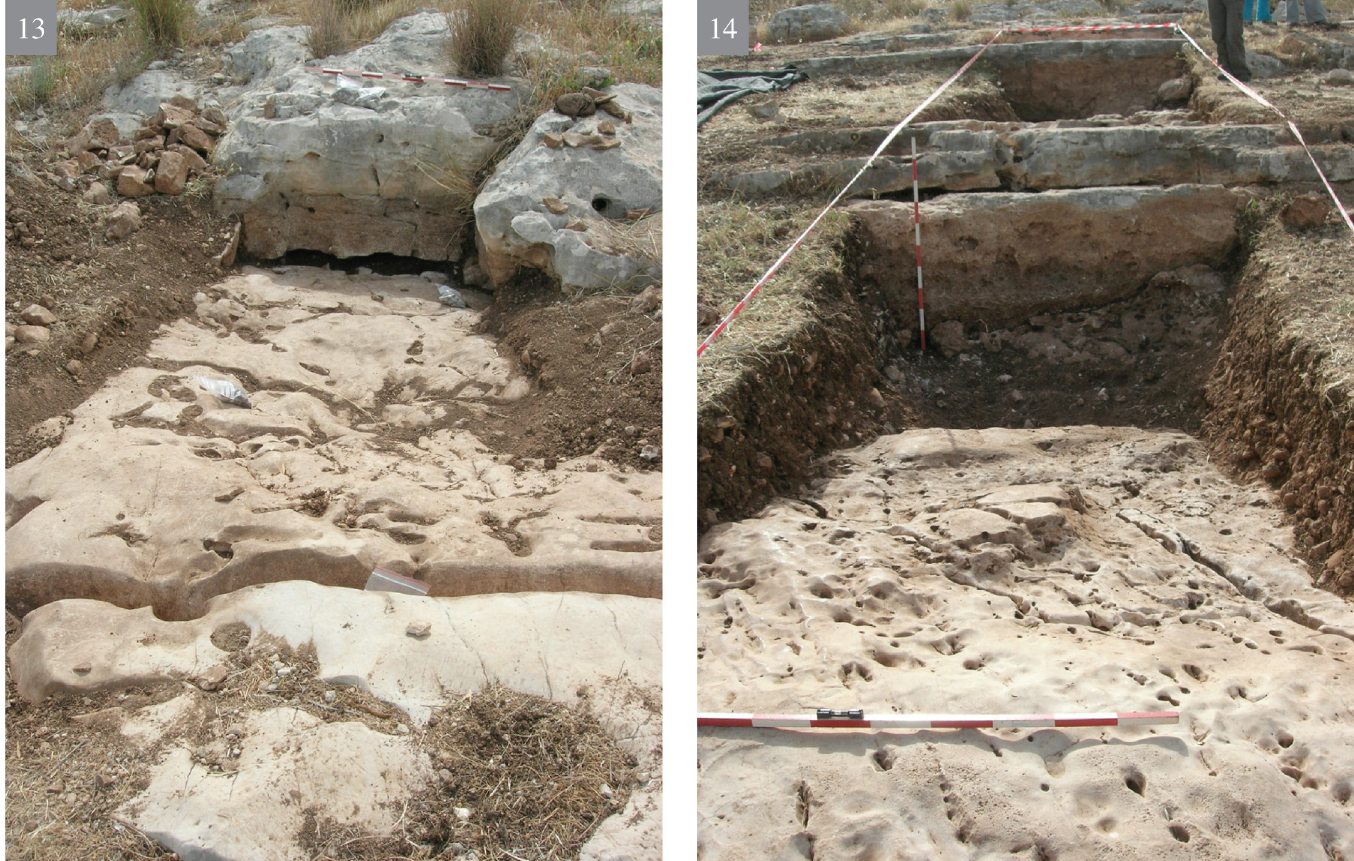
Fig 13. The excavation trench. (13–14) quarrying fronts, exploited surfaces and an enlarged